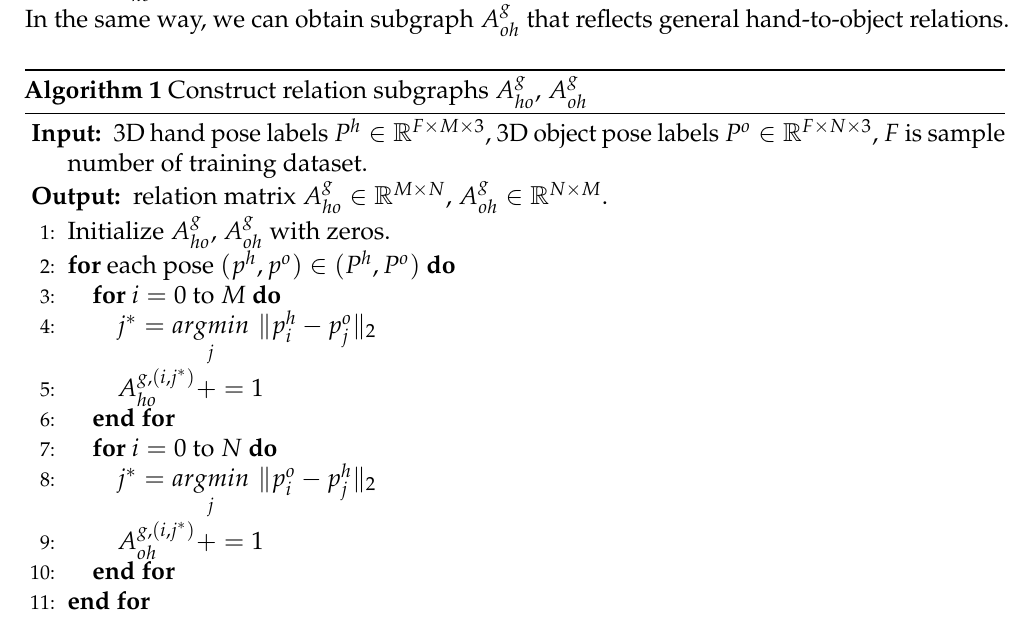
Algorithm 1 Construct relation subgraphs A g